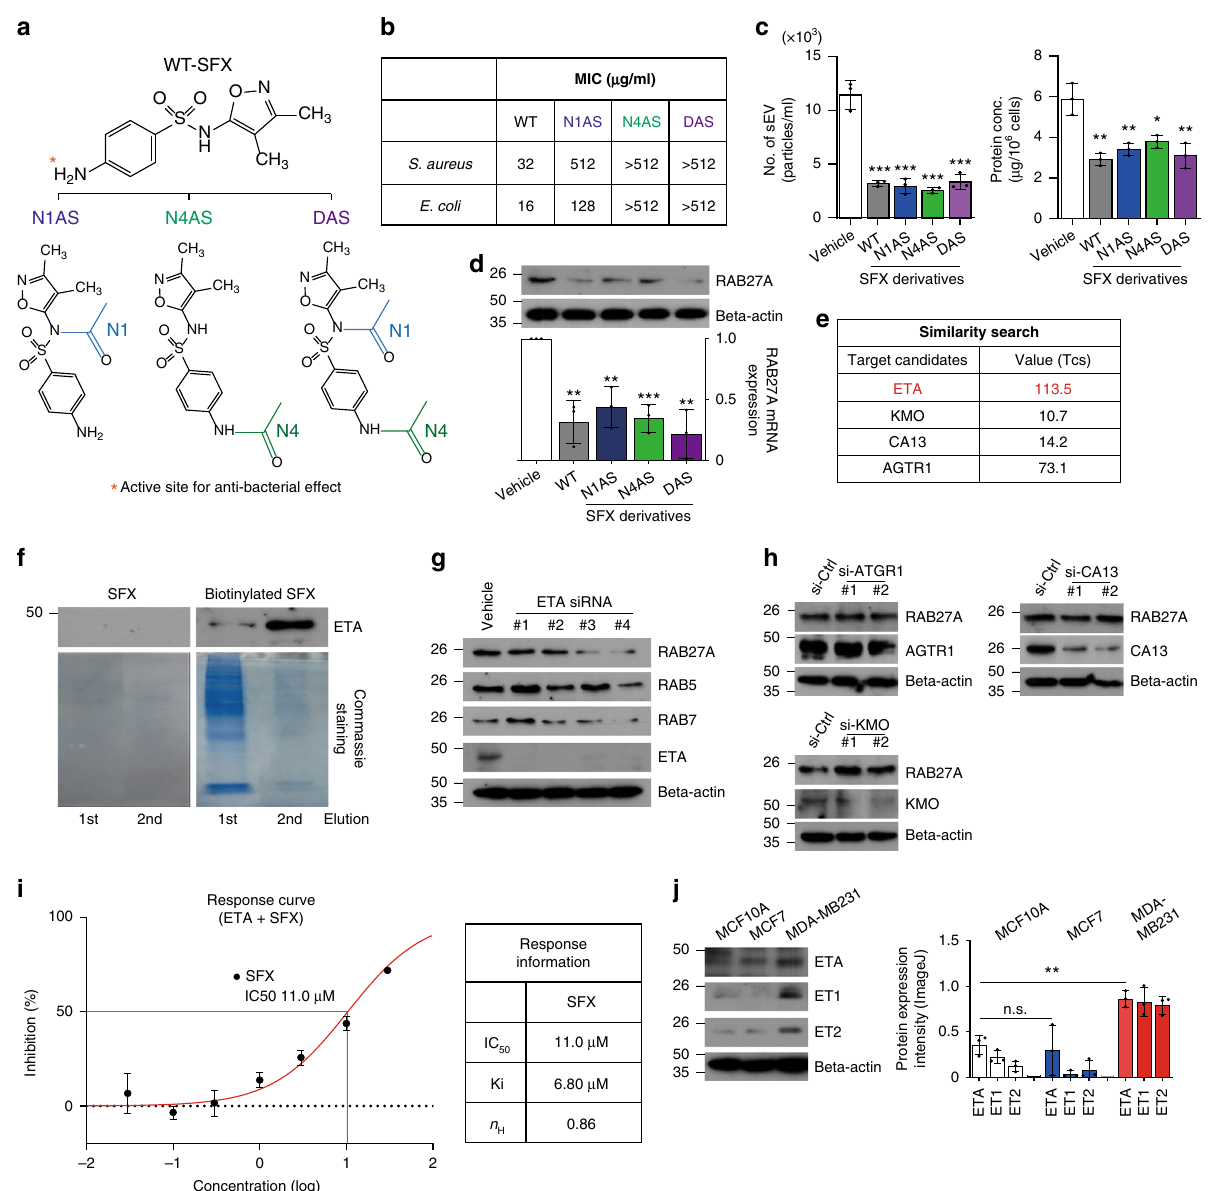
Fig. 4 Identi fi cation of the endothelin receptor as the novel target of SFX. a Schematic illustration of three acetylated SFX derivatives. N1, N1-acetylation site (blue). N4, N4-acetylation site (green). b The minimal inhibitory concentration (MIC) of SFX and its derivatives against Staphylococcus aureus ATCC 29213 and Escherichia coli ATCC 25922. c Measurement of the number of sEV and the amounts of sEV proteins. Left, the number of sEV. Right, the amounts of sEV proteins. n = 3. d Immunoblot (Top) and qRT-PCR analysis (bottom) of RAB27A in MDA-MB231 cells treated with 100 µ M SFX or its structural derivatives. e Candidate proteins for binding to SFX by searching binding DB. Tanimato coef fi cients (Tcs) as the measure of similarity are summarized. f Detection of ETA by immunoblot. Eluted parts from the membrane fraction of MDA-MB231 cells were used for biotin-based pull-down assay. WT-SFX was used as a negative control. n = 3. g Immunoblot of various proteins in MDA-MB231 cells after transfection of different ETA siRNAs. AccuTarget TM siRNA was used for control siRNA. n = 3. h Immunoblot of Rab27a protein after transfection of each siRNA speci fi c to AGTR1, CA13, or KMO into MDA- MB231. n = 3. i Dose response curve for the inhibition of binding of 125 I-ET1 to the human ETA receptor. IC 50 , the half maximal inhibitory concentration. Ki the inhibitory constant, n H Hill coef fi cient. j Immunoblot of ETA and its ligand, ET1 and ET2 in MCF10A, MCF7, and MDA-MB231 cells. n = 3 per cell line. Experiments were performed with 95% con fl uent cells. Signi fi cance was determined using an unpaired two-tailed Student ’ s t -test. *** p < 0.001, ** p < 0.005 and * p < 0.05. Error bar, SD. Source data ( b – d , i – j ) are provided as a Source Data fi